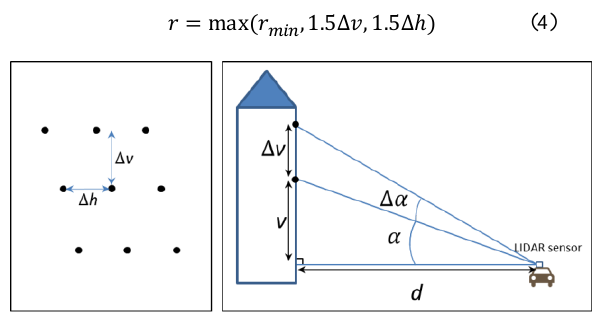
Figure 3: Left: Horizontal and vertical sampling. Right: The vertical sampling ∆𝒗 depends on the sensor distance 𝒅 and angle step ∆∝